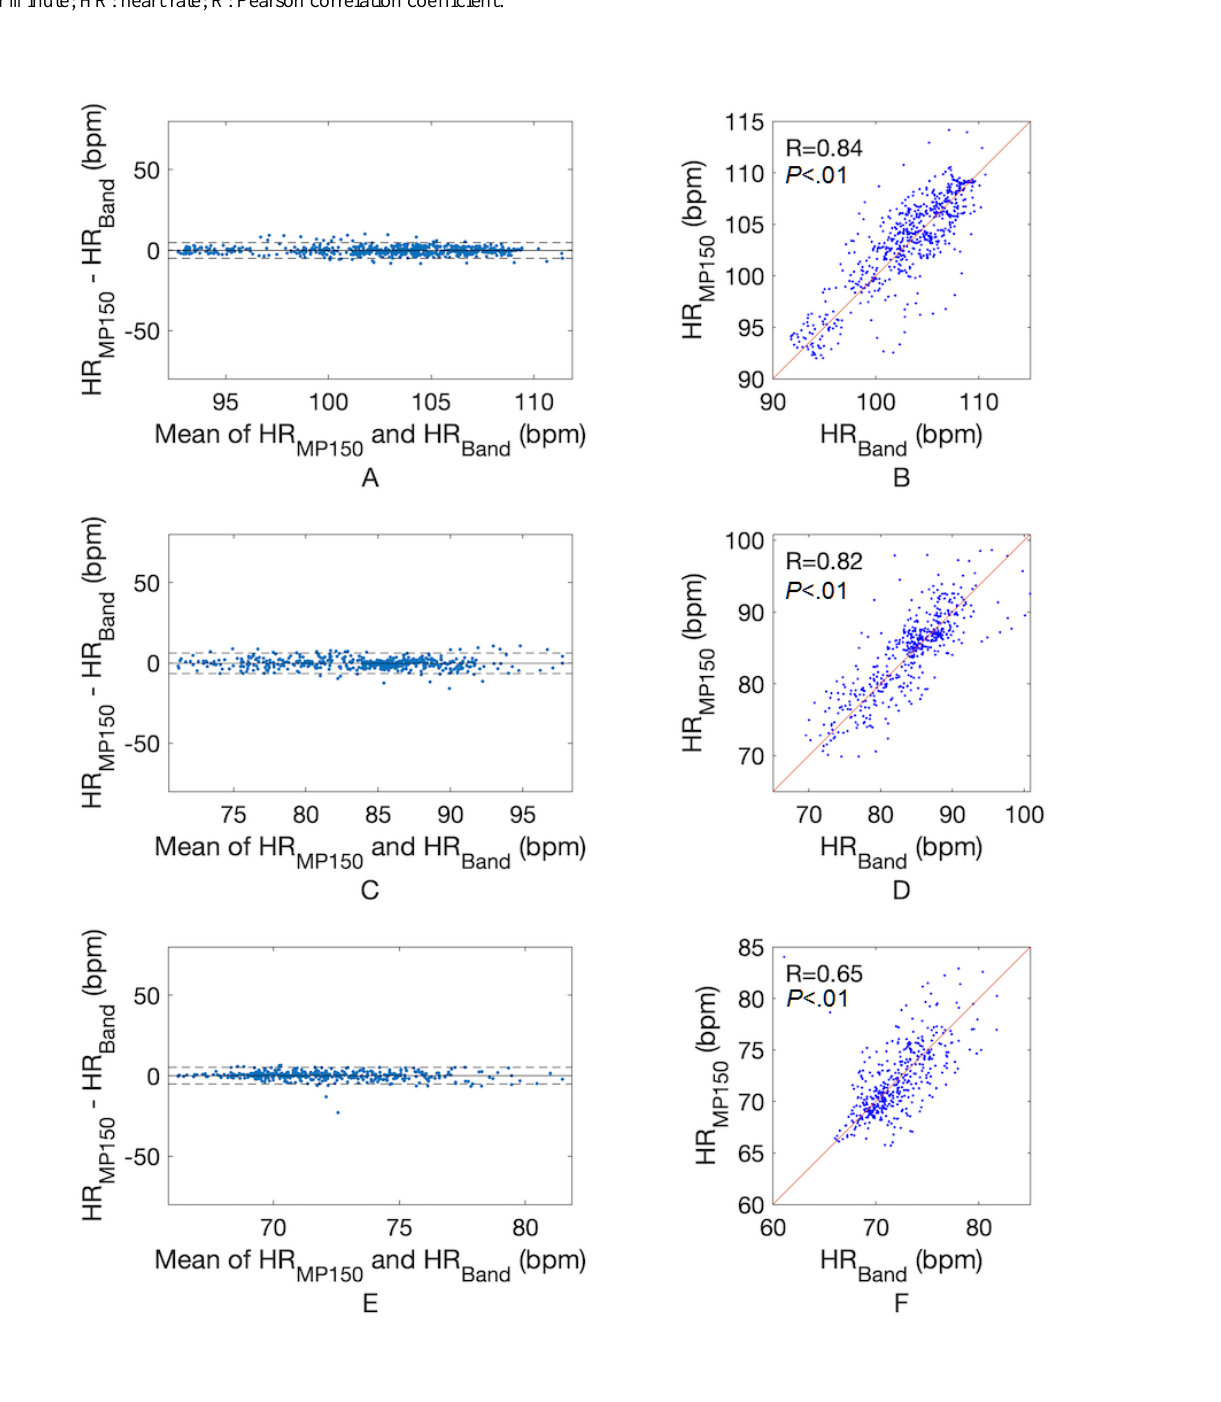
Figure 9. Heart rate change by applying the moving average filter (MAF). A. In standing position without MAF. B. In standing position with MAF. C. In sitting position without MAF. D. In sitting position with MAF. E. In supine position without MAF. F. In supine position with MAF. bpm: beats per minute; HR: heart rate; R: Pearson correlation